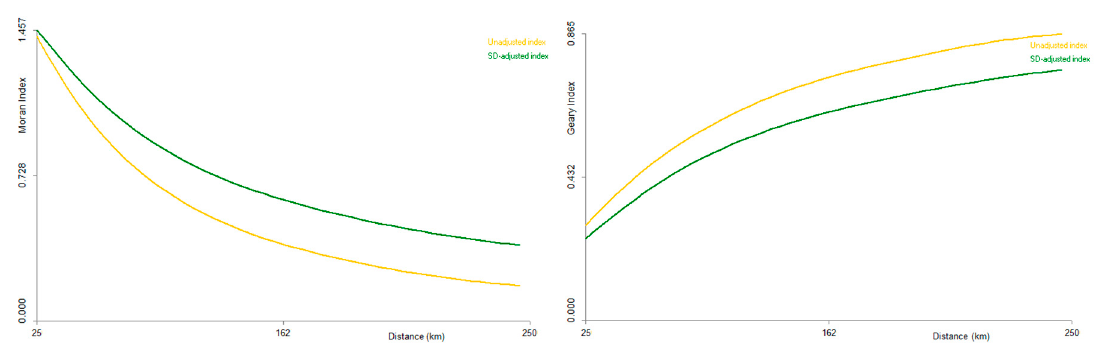
Figure 4. Semi-variogram of the percentage of votes cast in favor of Emmanuel Macron.